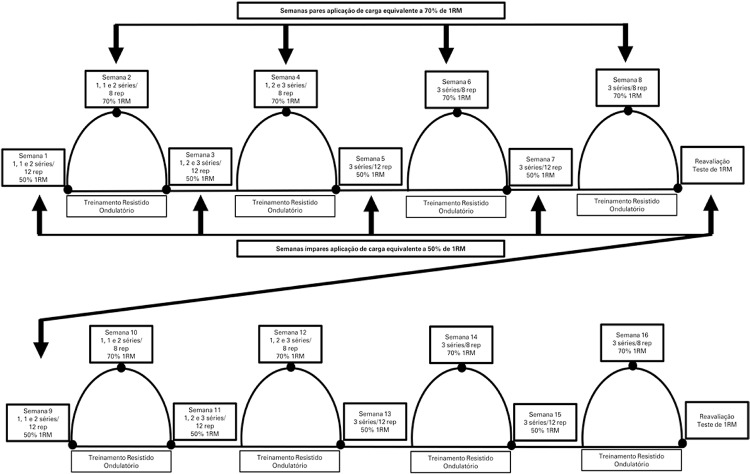
Desenho experimental da periodização ondulatória. 1RM: teste de uma repetição máxima; Rep: repetições